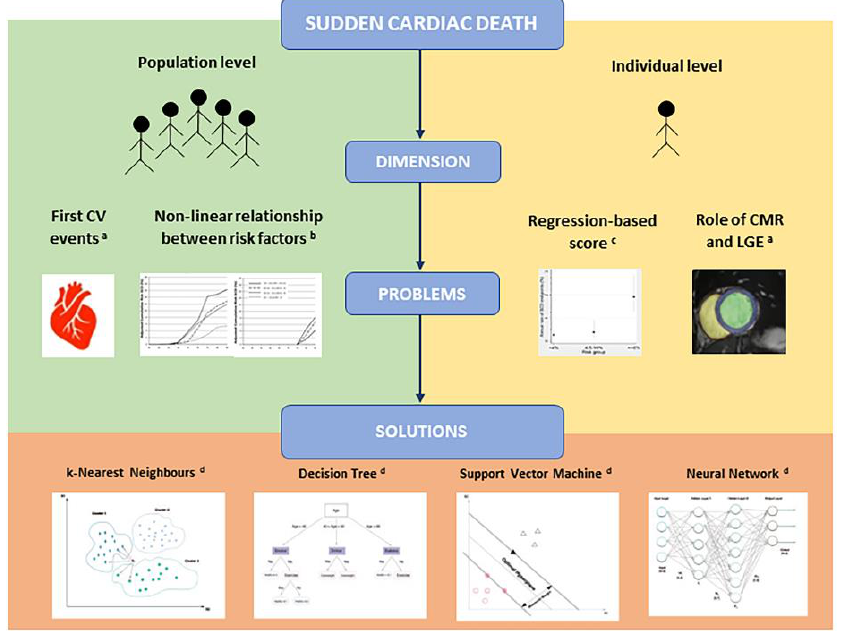
Figure 4. The figure retraces the structures of review. Sudden cardiac death (SCD) has been addressed in the two different dimensions of population level and individual level. Current evidence reveals many problems in the accuracy of risk stratification strategies. Solutions proposed in this review suggest the use of ML models to improve patient selection for an implantable cardioverter defibrillator for primary prevention. (a) Adapted from Leiner et al. [64]; (b) lifetime risk for SCD in male population at index age 45 years (left image) and 75 years (right image), adapted from Bogle et al. [6]; (c) annual rate of SCD end point within 5 years stratified according to HCM Risk-SCD), adapted from O’Mahony et al. [50]; (d) adapted from Al’Aref et al.